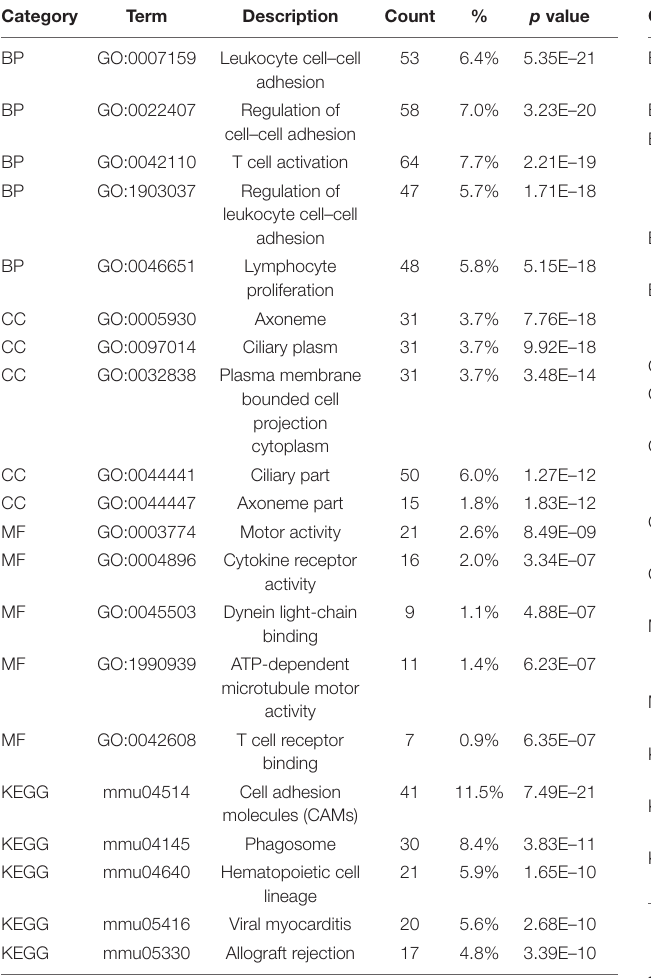
TABLE 2 | Functional enrichment analysis of upregulated genes in the old mouse ovary compared to young mouse. Category Term Description